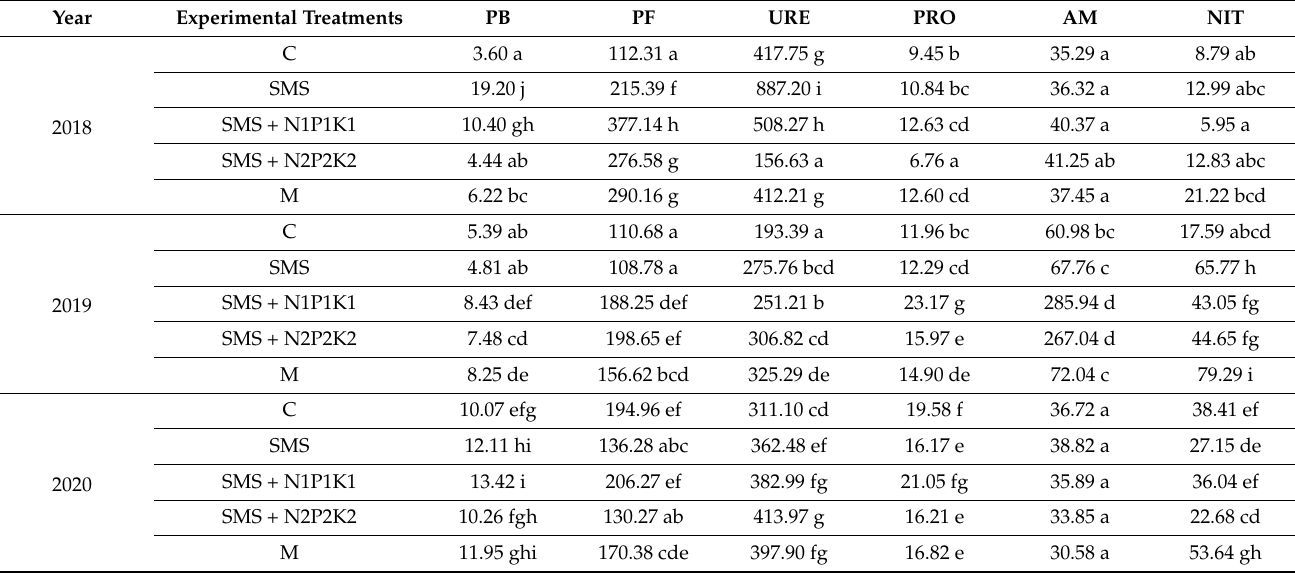
Table 3. Microbiological, enzymatic, and biochemical activity in soil (Annual